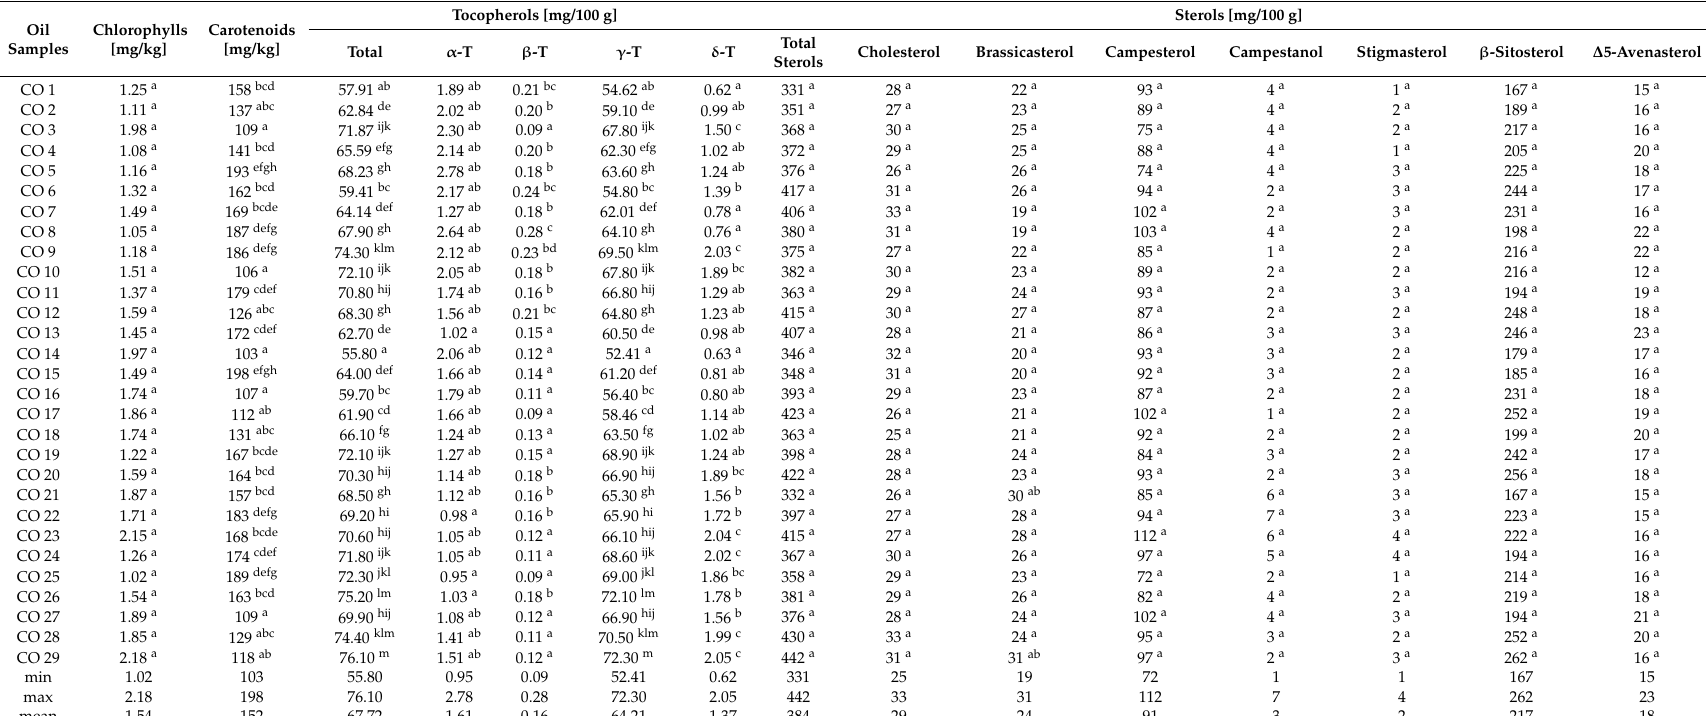
Table 3. The content of pigment, tocopherols and phytosterols in analyzed